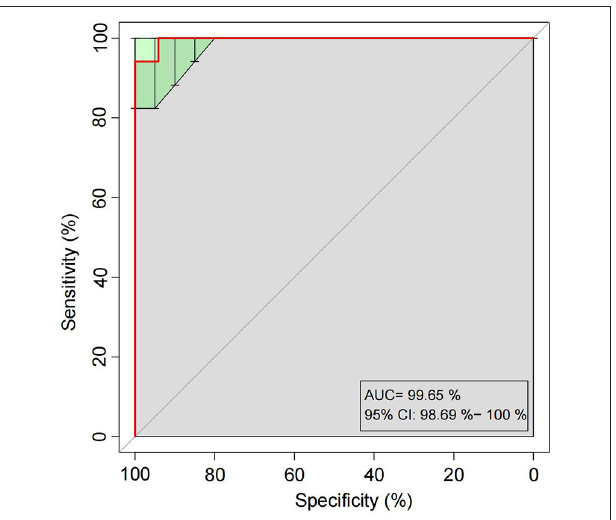
FIGURE 6 | Receiver operating characteristic (ROC) curves built with twenty bacterial families for HCC-MVI